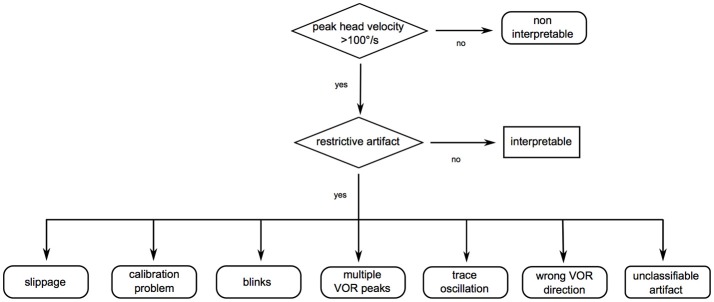
Flowchart to scan for restrictive mistakes. Restrictive mistakes are artifacts preventing a confident overall video head impulse test (vHIT) interpretation of one participant (restrictive artifacts) or an insufficient head velocity stimulus in all vHIT traces of one participant. First, sufficient peak head velocity was checked (>100°/s). In a second step, data were scanned for artifacts possibly restricting overall interpretability [in analogy to (10)]: (1) Slippage: phase shift of the head with respect to eye motion, probably due to a loose goggle strap, the examiner touching the goggle strap while applying the head impulse or stretching the patient's skin. (2) Calibration problems: mostly due to participants not following the calibration instructions. Signs pointing to an insufficient calibration may be inappropriately high (>1.3) or low (< 0.79) vestibulo-ocular reflex (VOR) gain values without consecutive re-fixation saccades. (3) Blinks: oscillations crossing the baseline (no saccades, ≥75% of peak eye velocity). (4) Multiple VOR peaks: two or more eye velocity peaks during head movement (no saccades, ≥25% of peak eye velocity), probably due to the examiner touching the goggles, mini-blinks or impaired pupil detection. (5) Trace oscillations: oscillations (no saccades, < 25% of peak eye velocity during head movement and < 75% of peak eye velocity after head movement), probably due to impaired pupil detection. (6) Wrong VOR direction: no eye movement or eye movement in the same direction as the head movement, probably due to patient inattention. (7) Unclassifiable artifact: any other artifact, which restricts interpretation, but does not match the criteria above.